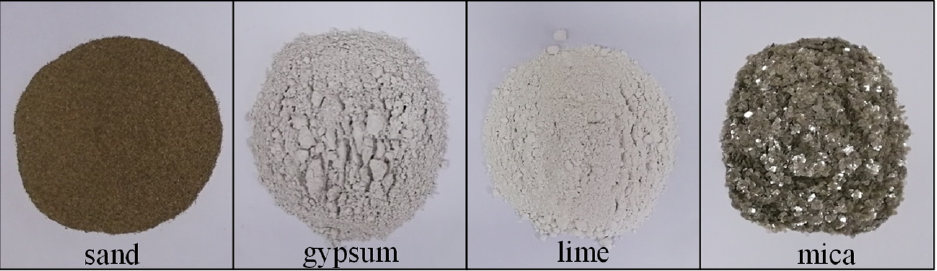
Figure 6. Main similar materials.